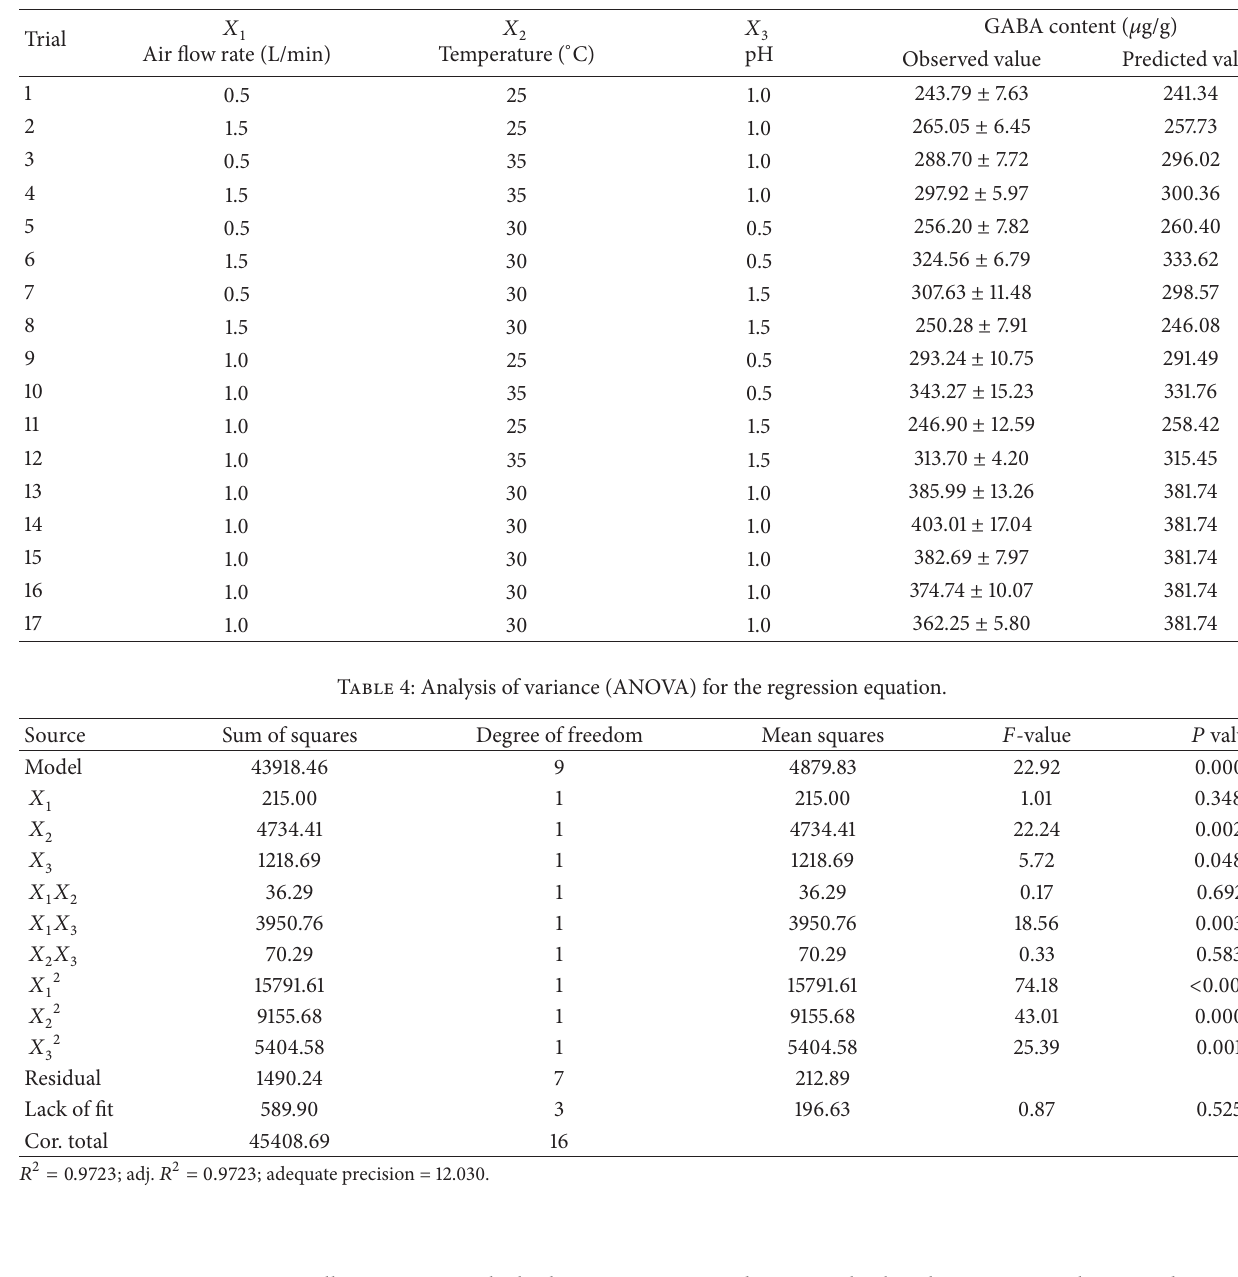
Table 3: Box-Behnken design and experiment data for GABA content from germinated tartary buckwheat.